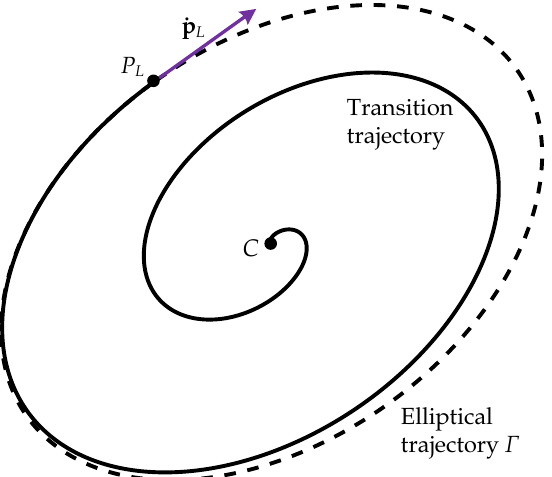
Figure 1. A launch motion: the EE starts at C , moves along a trajectory and launches an object at P L .